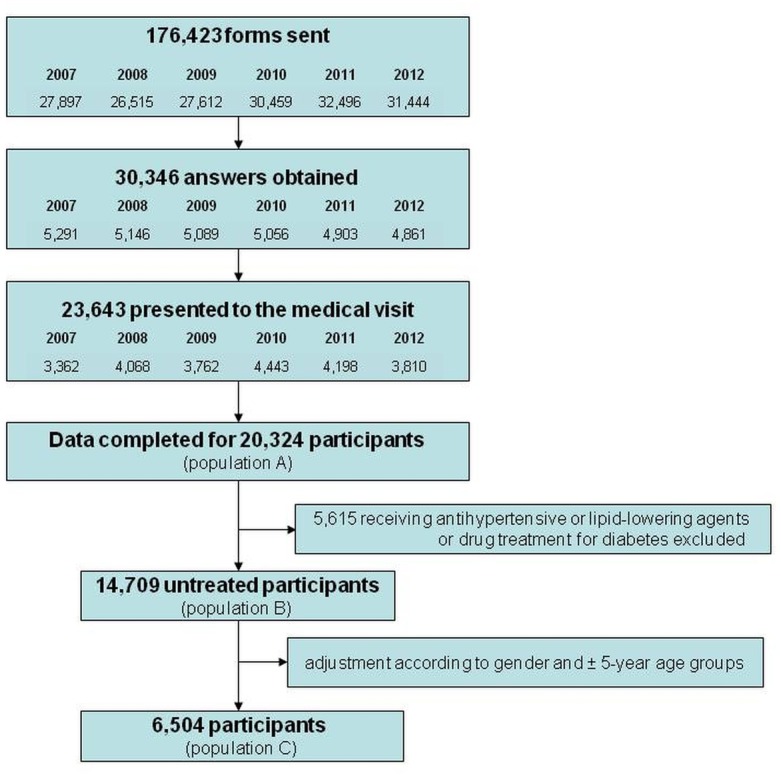
Selection of the CARVAR 92 study populations.